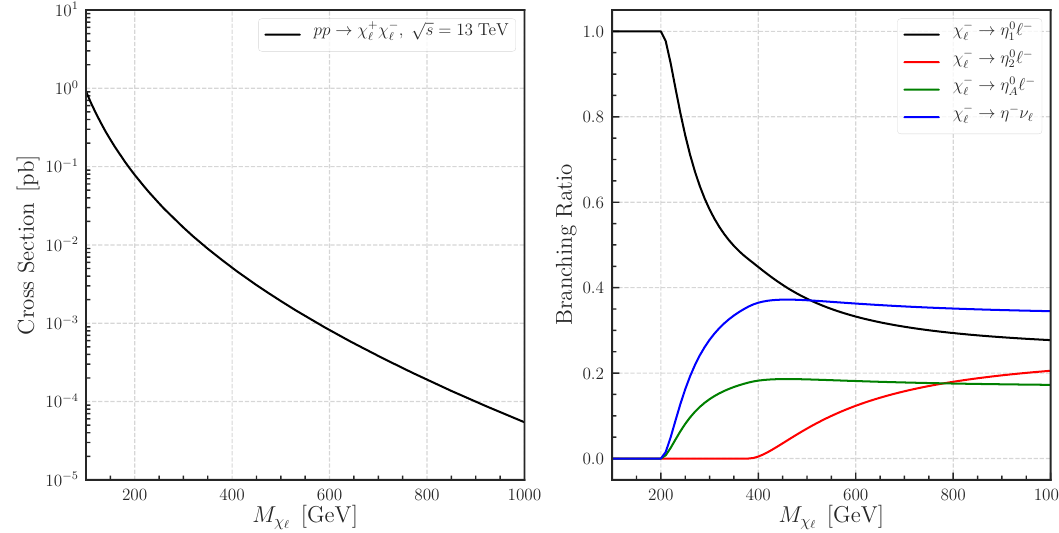
Figure 8 . Left: cross section of pp p s = 13 TeV. Right: branching ratios of (cid:31) ‘ in the model with Y D = 1 with ( m (cid:17) = (80, 200, 200, 380) GeV and (cid:18) = (cid:25)= 4.